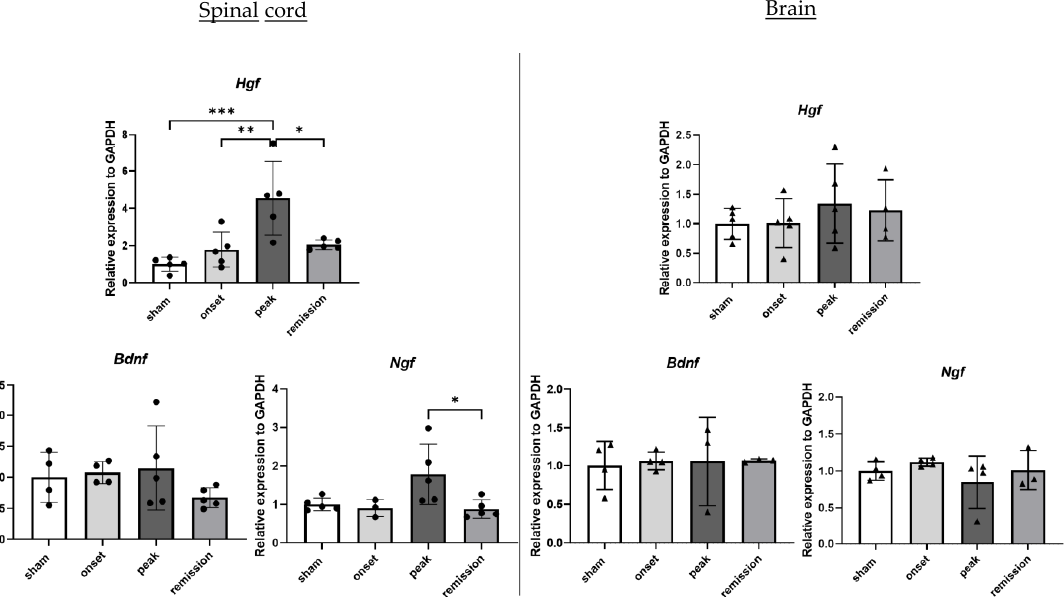
Figure 7. Differential expression of genes representative of repair mechanisms in CNS organs during the different phases of PLP-induced EAE. The levels of mRNA transcripts for the selected genes relative to Gapdh were measured in the spinal cord ( left ) and brain ( right ) samples isolated from adjuvant controls and EAE mice on the onset, peak, and remission phases by RT-qPCR. A number of 3 to 5 mice was used in the experiment. Each symbol represents a sample. * p < 0.05, ** p < 0.01, *** p < 0.001, one-way ANOVA.